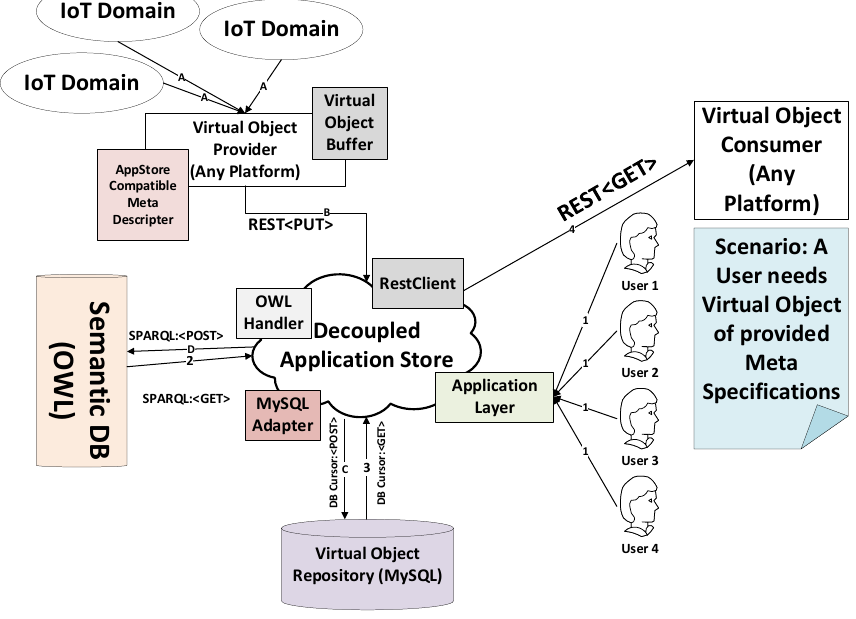
Figure 2. Detailed modular architecture with example use case